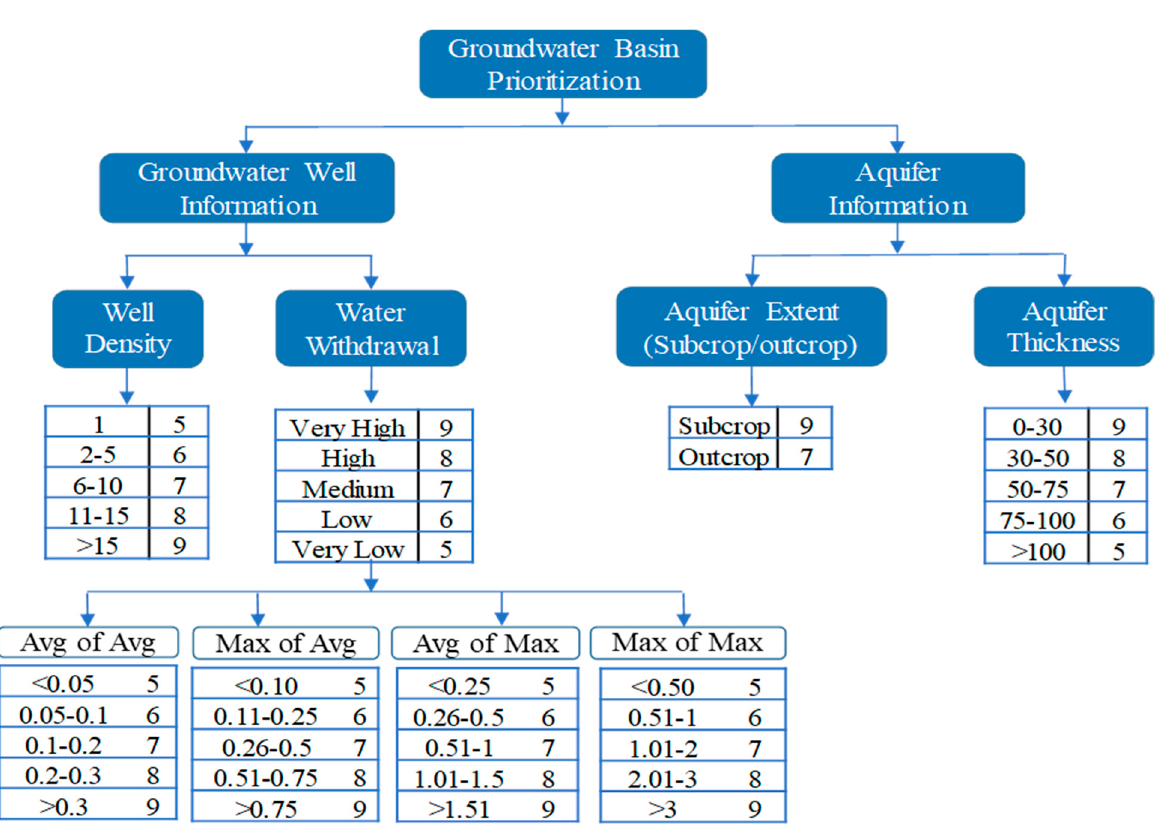
Figure A2. Reclassified maps that are generated to identify the groundwater vulnerability zones. ( a ) Permitted well den- sity per tax map; ( b ) Spatial distribution of aquifer thickness; ( c ) Permitted water withdrawal rate per tax map; and ( d ) Spatial distribution of outcrop and subcrop areas. Figure A1. Developed decision hierarchy to identify the groundwater vulnerability zone.